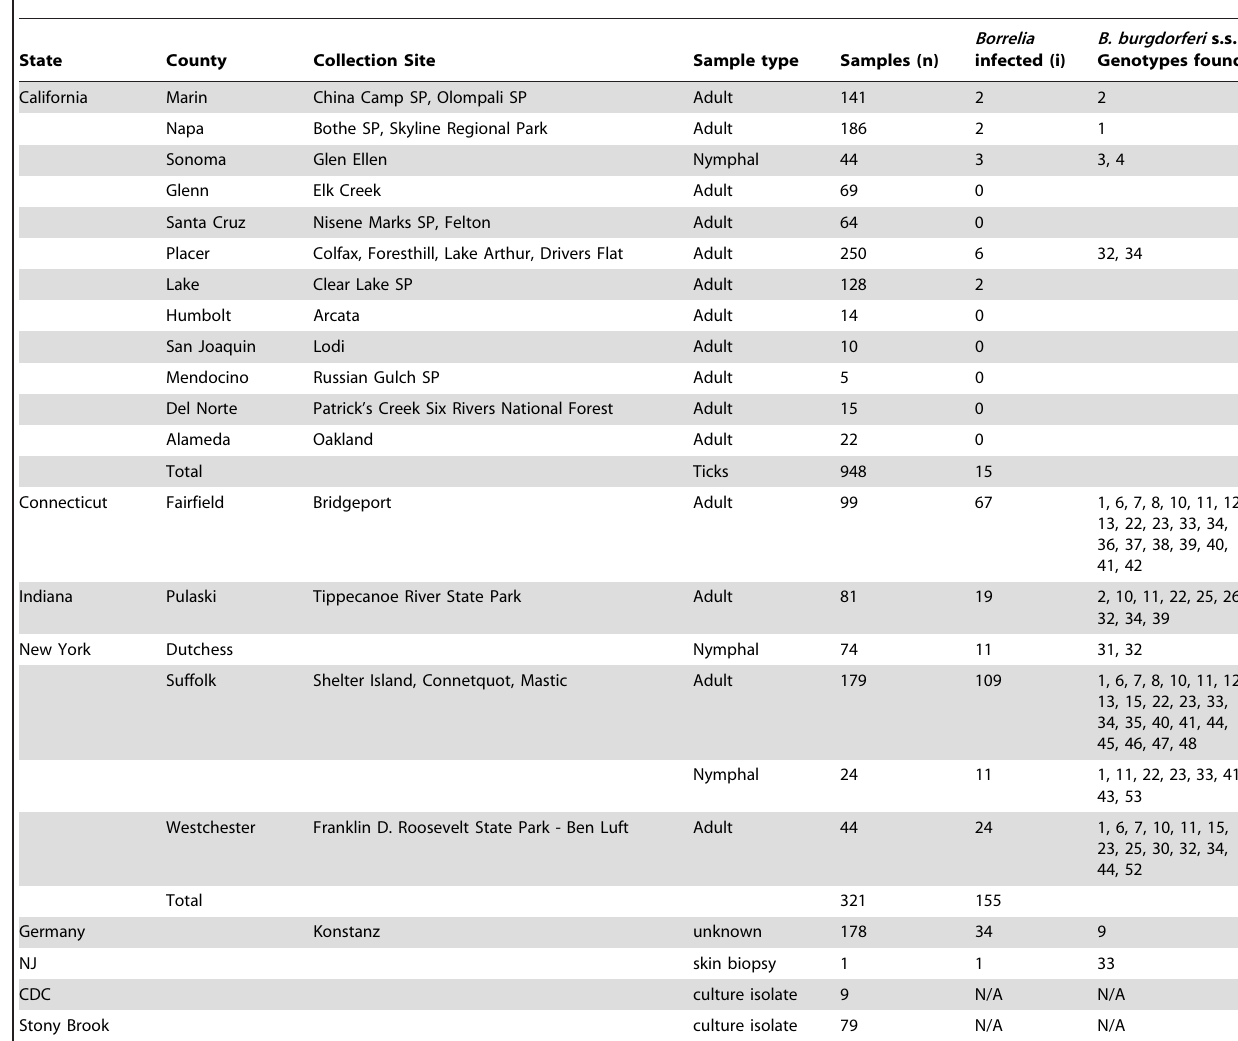
Table 2. Sample origin locations and prevalence of Borrelia infected